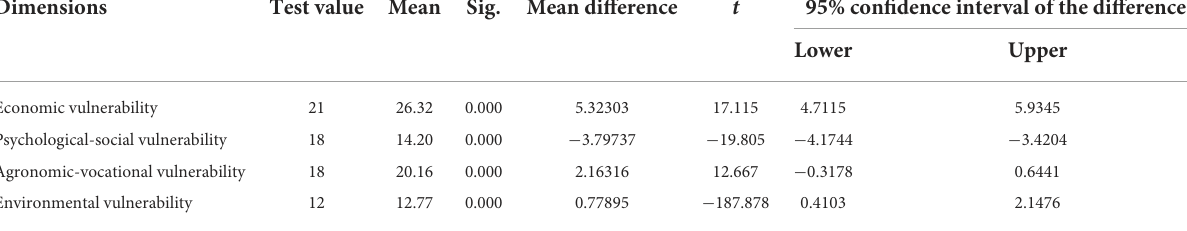
TABLE 5 The comparison of mean dimensions of farmers’ vulnerability with the mean intervals. Dimensions Test value Mean Sig.